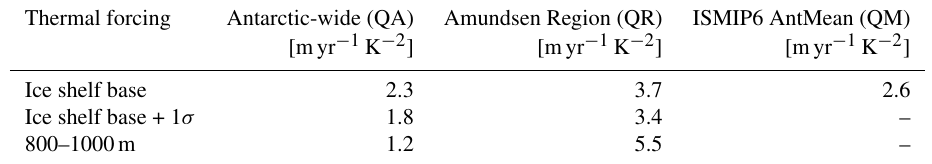
Table 5. Sensitivity of calibration parameter of the quadratic parameterisation to thermal forcing. Values indicate median basal melt sensi- tivity in myr − 1 K − 2 for calibrated γ values based on three types of thermal forcing. The Antarctic-wide calibration (QA) and Amundsen Region calibration (QR) are shown. For comparison the median value of the AntMean calibration that is used in ISMIP6 (QM) is shown. The first thermal forcing type is the thermal forcing as shown in Fig. 3, which is based on the bias-adjusted ocean subsurface temperature time series of the ESMs near the ice shelf base. The second type is based on the same ocean temperature time series raised with one standard deviation (1 σ ) that expresses the spread between the ocean reanalysis products (GREP σ in Table 1). The third type is the thermal forcing at 800–1000m